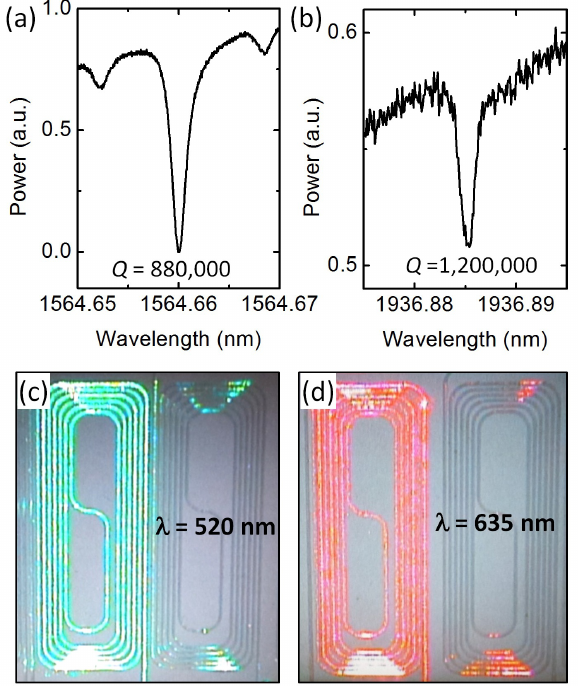
Figure 2: Fundamental TE mode resonances near (a) 1550 nm, and (b) 1950 nm wavelengths. Spiral waveguides show visible light transmission when (c) 520 nm and (d) 635 nm lasers are introduced into the